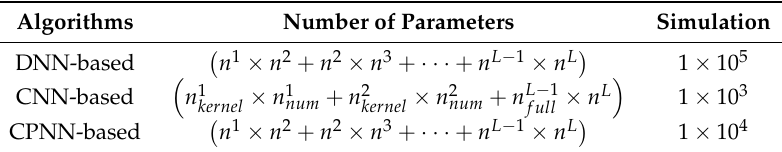
Table 2. The number of parameters in the retraining